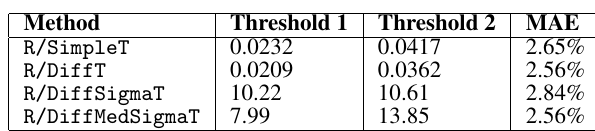
Table 1. Best threshold and performance for classification methods. MAE: Mean Absolute Error.